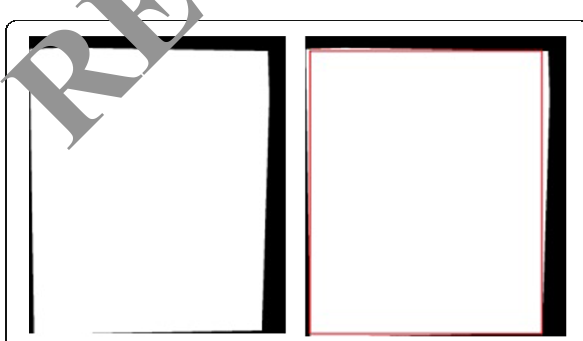
Fig. 5 The result of MSM